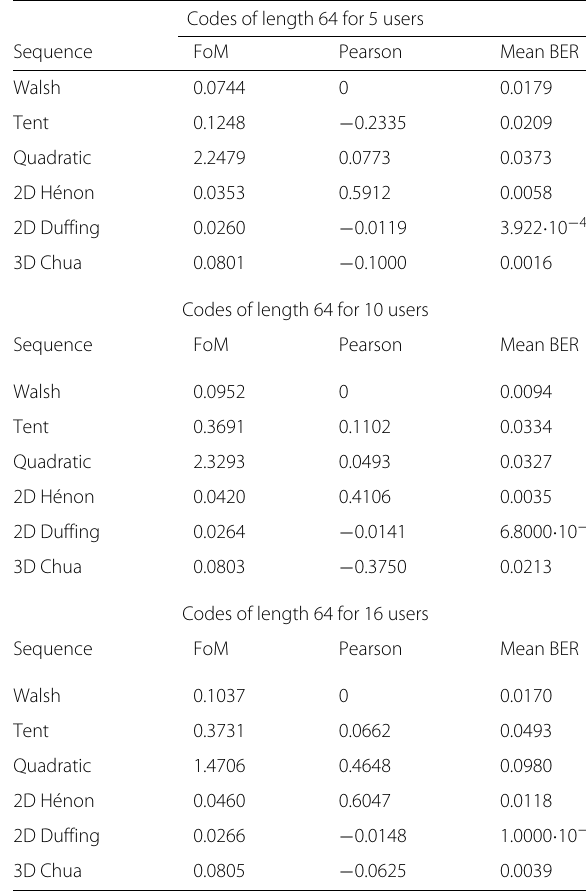
Table 1 Correlation properties for codes of length 32 Table 2 Correlation properties for codes of length